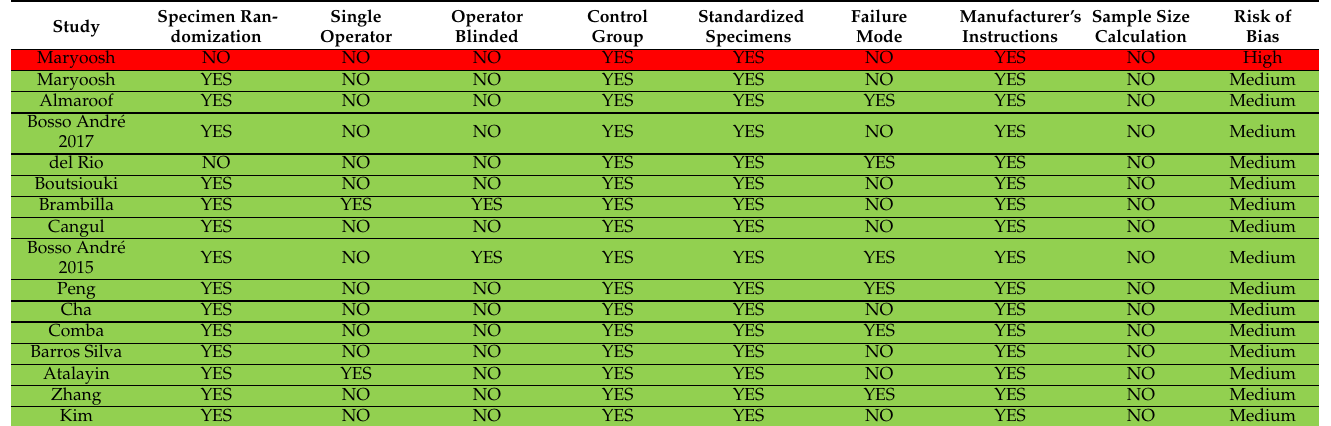
Table 4. Qualitative synthesis (risk of bias assessment). Study Specimen Ran-